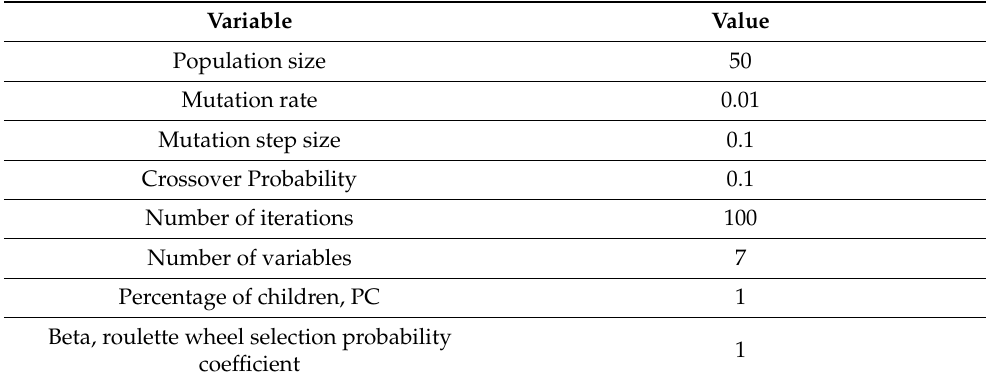
Table 4. Genetic algorithm optimization parameters.